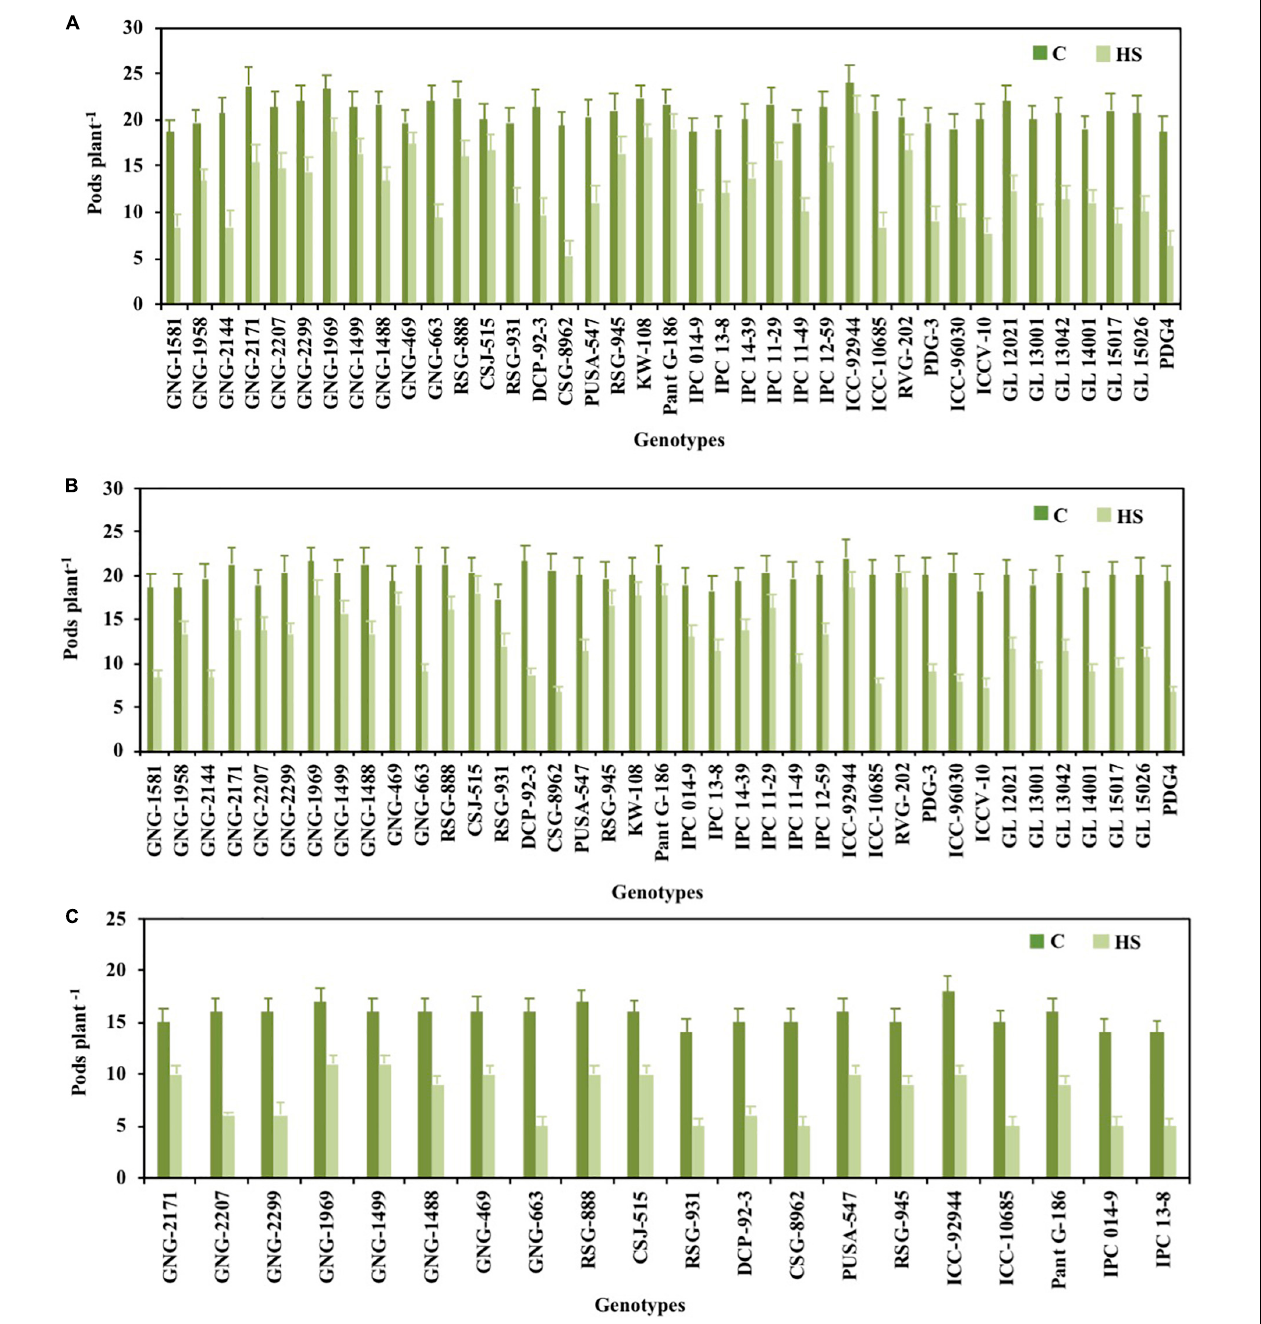
FIGURE 2 | Pod number plant - 1 of chickpea genotypes under control (normal-sown; C) and heat stress (late-sown; HS) environment during 2017–2018 (A) , 2018–2019 (B) and in control environment of growth chamber (GC; C-control; HS-heat stress; C) . LSD values ( P < 0.05); genotype × treatment: 2.9 (2017–2018), 3.6 (2018–2019), 3.1 (GC). Values are means + SE. ( n = 3).